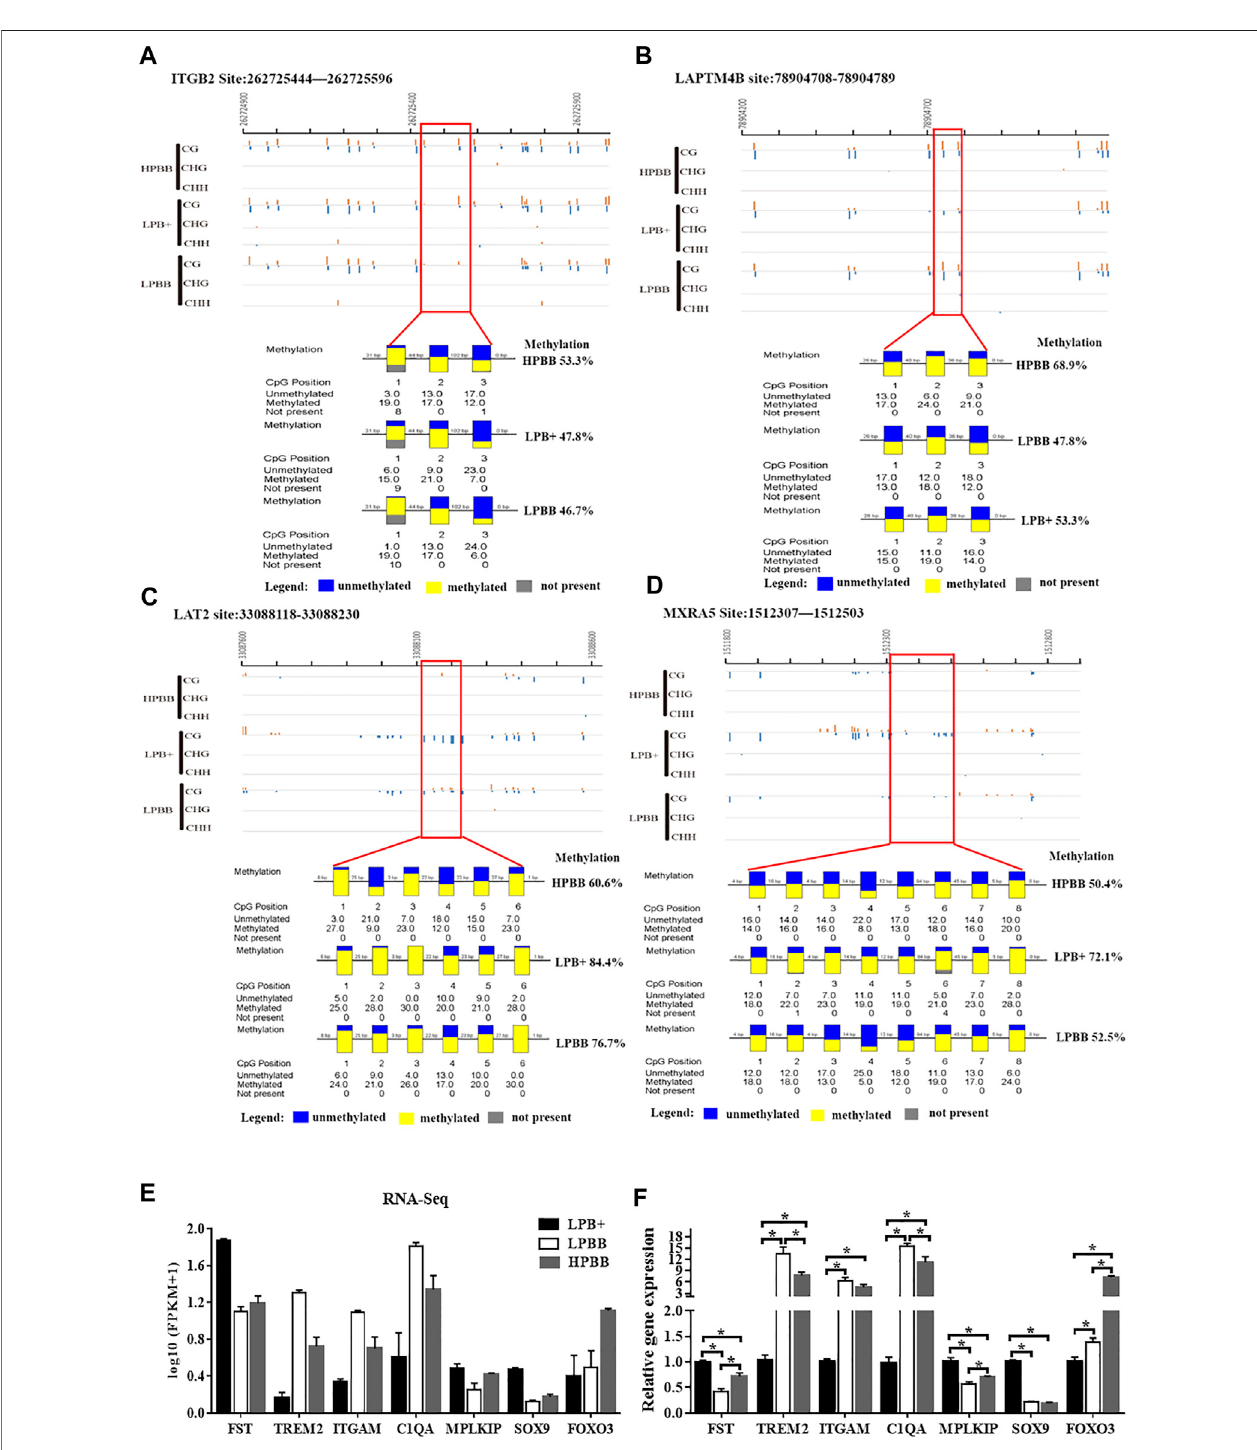
FIGURE5| ValidationofWGBSandRNA-seqdatabyBSPandqRT-PCR,respectively. (A,B) ADMRacrossthedifferentgroupsinthepromoteroftheITGB2and LAPTM4B from 262725444 to 262725596 and from 78904708 to 78904789, respectively. (C) A DMR across the three groups in the intron of LAT2 from 33088118 to 33088230. (D) A DMR across the three groups in the distal intergenic region of MXRA5 from 1512307 to 1512503. Each box corresponds to one CpG position in the genomic sequence. Blue indicates unmethylated and yellow indicates methylated. (E) Seven mRNAs were randomly selected from the RNA-seq data. RNA-seq data are presented as log 10 (FPKM+1). FPKM: Fragments Per Kilobase of transcript per Million fragments mapped. (F) Validation of the DEGs using qRT-PCR.